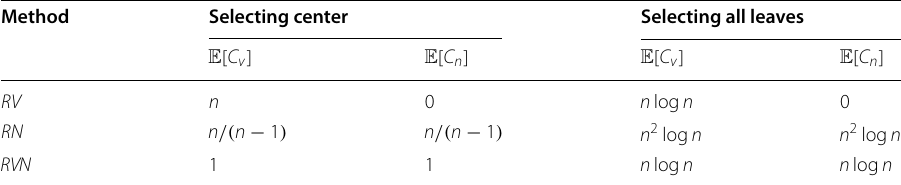
Table 2 An analysis of costs C v and C n in a star graph of n vertices